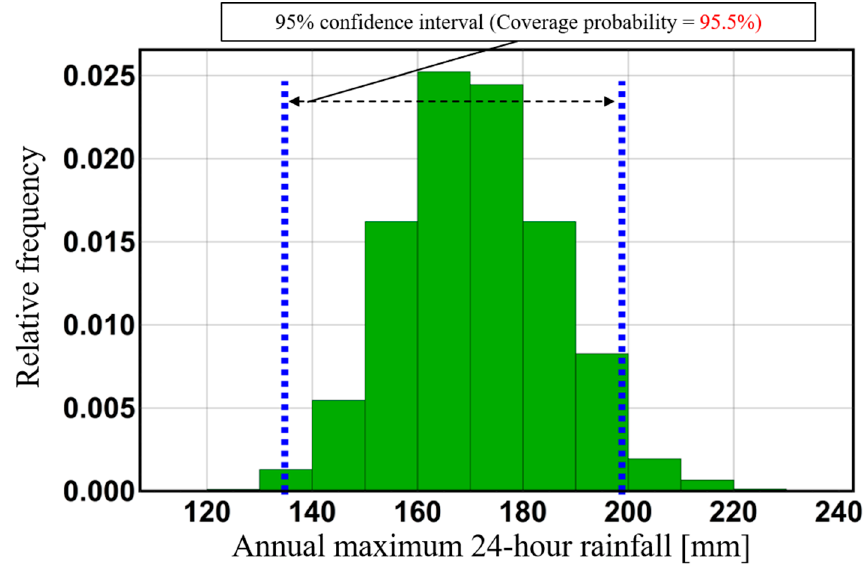
Figure 15. 95% confidence interval of 100-year annual maximum 24-h rainfall based on probability limit method test for past climate vs. histogram of 100-year annual maximum 24-h rainfall generated by resampling of past experiment data.